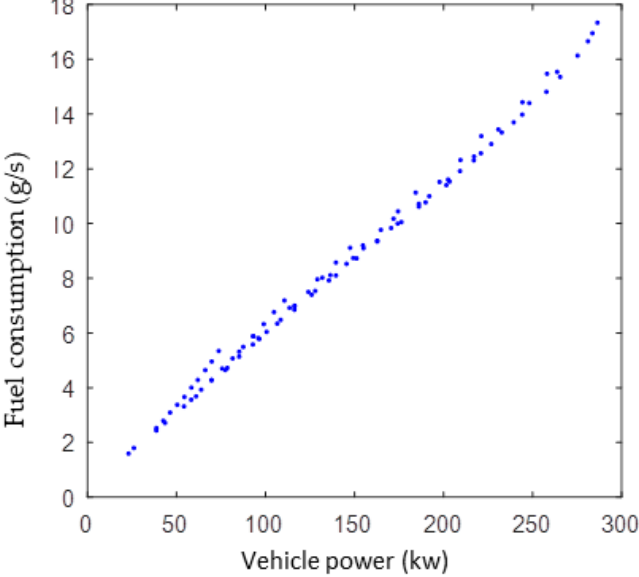
Figure 1. Engine fuel consumption (from the engine bench test).